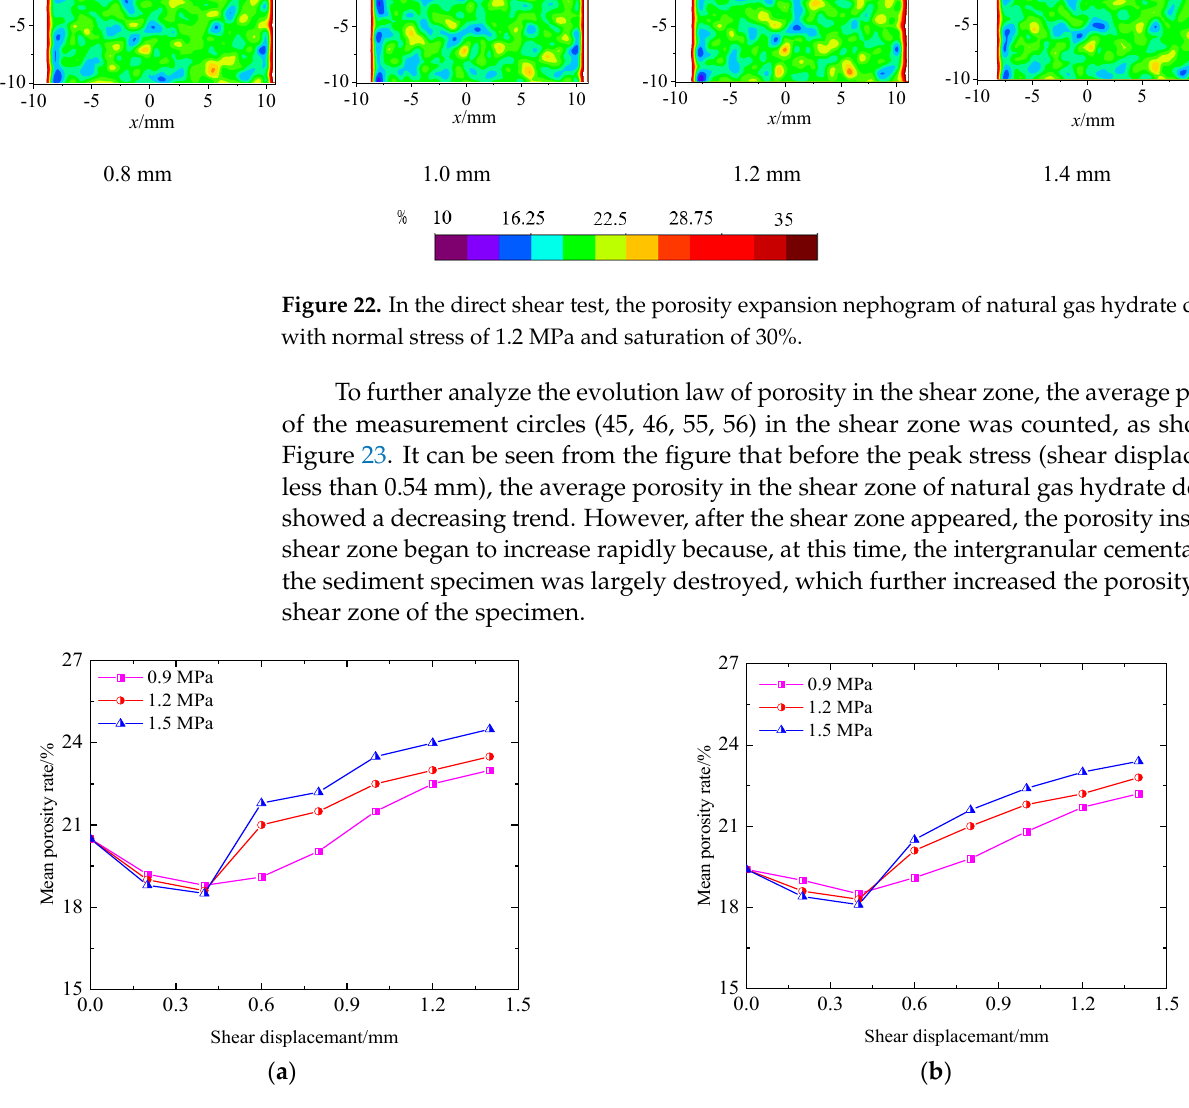
Figure 23. In direct shear test, the local porosity evolution curves of natural gas hydrate deposits under different conditions.: ( a ) S h = 20%, ( b ) S h = 30%.